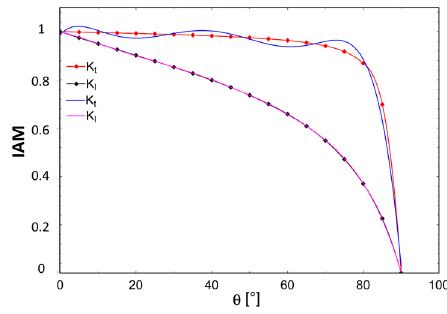
Figure 10. Incidence angle modifiers for longitudinal ( K (cid:2922) ) and transverse ( K (cid:2930) ) directions.